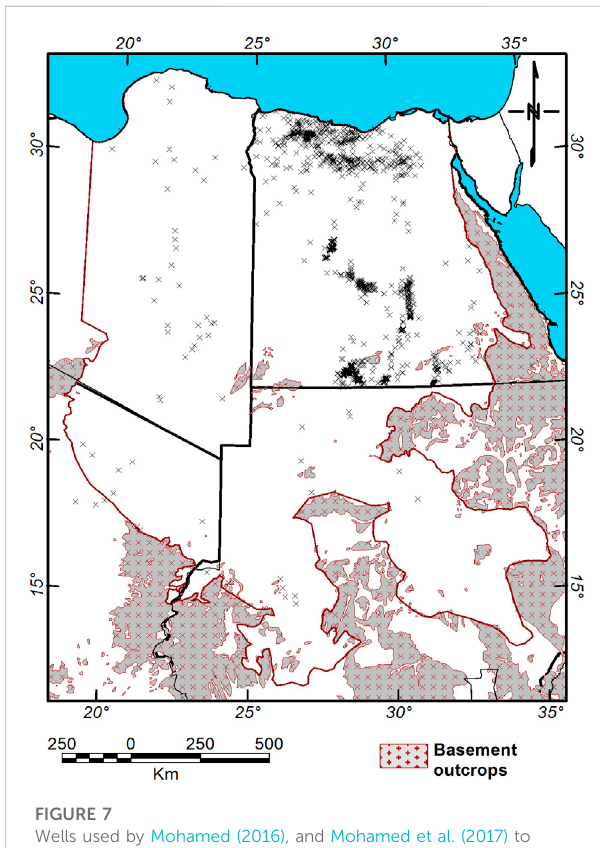
FIGURE 7 Wells used by Mohamed (2016), and Mohamed et al. (2017) to constrain the gravity pro fi les and the cross